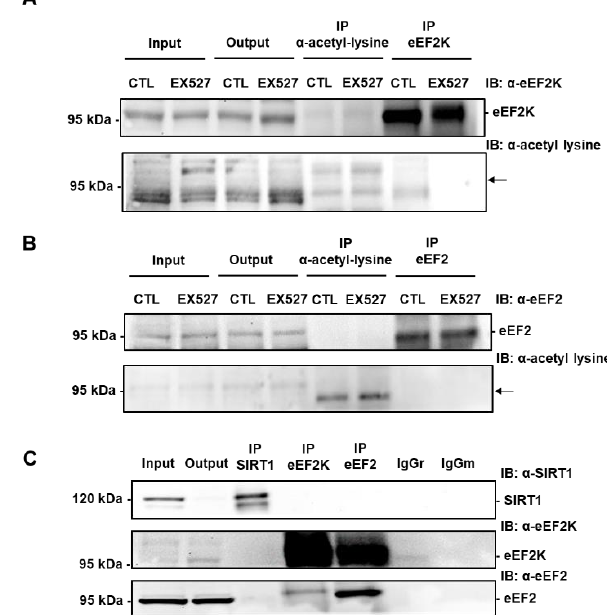
Figure 7. eEF2K and eEF2 are not acetylated on lysine and do not co-immunoprecipitate with SIRT1 in H9c2 cells. ( A ) Immunoprecipitation of lysine-acetylated proteins or eEF2K from lysates of H9c2 cells treated or not with 50 µM EX527 (SIRT1 inhibitor) followed by immunoblotting with anti-eEF2K or anti-acetyl lysine antibodies (n = 3). ( B ) eEF2 was immunoprecipitated from lysates of H9c2 cells treated or not with 50 µM EX527 and its level of acetylation was analyzed by immunoblotting with anti-acetyl lysine antibodies (n = 3). The location of eEF2K and eEF2 is shown by an arrow. ( C ) The physical interaction between endogenous SIRT1 and eEF2K or eEF2 was analyzed by co- immunoprecipitation. Either SIRT1 or eEF2K or eEF2 was immunoprecipitated from H9c2 lysates and